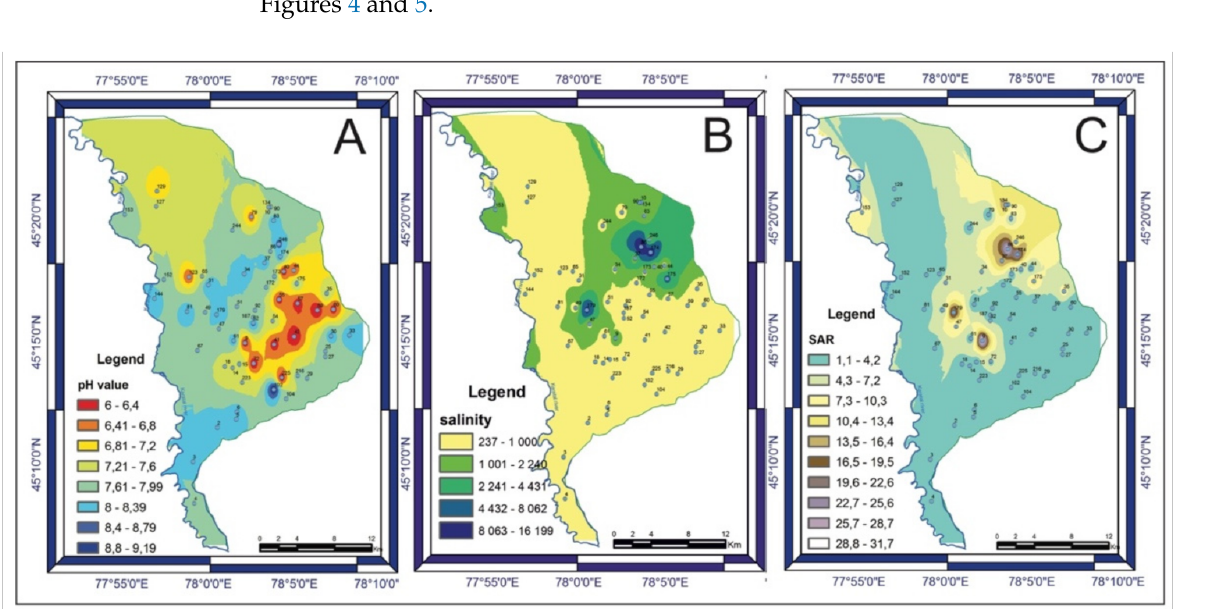
Figure 4. Maps of the spatial distribution of pH ( A ), salinity ( B ), and SAR ( C ) for the pre-vegetation period.